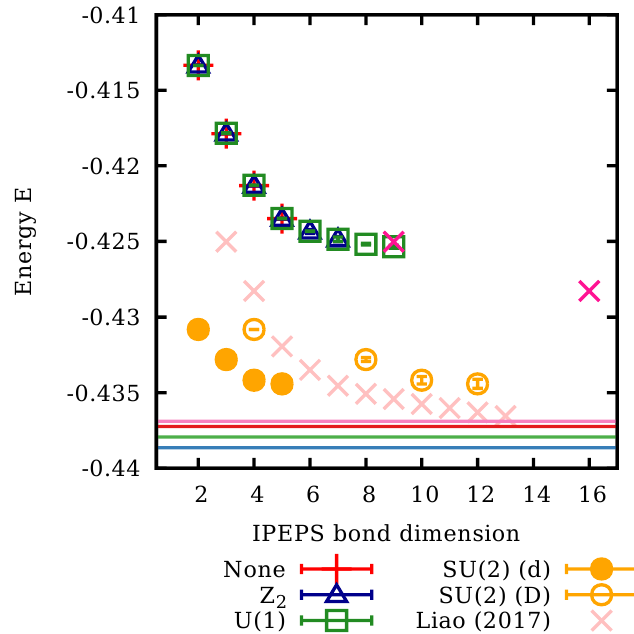
Figure 5: Ground state energy per spin on the kagome lattice. The square lattice mapping leads to energies which are considerably worse than the current best es- ≈ 0.437 (values from [ 50 ] , [ 51 ] , [ 52 ] , [ 17 ] shown as lines in top-down timates E 0 order, 9-site PESS from Ref. [ 51 ] as pink